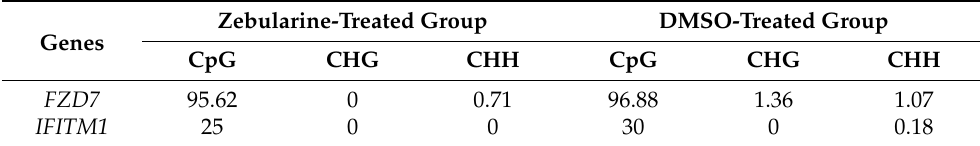
Table 2. Percentage of methylated cytosines in the three types of contexts.